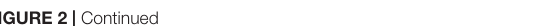
(human initiator vs. robot initiator). Participants completed two sessions of 60 min, 1 week apart. Assignment to conditions and group was performed using